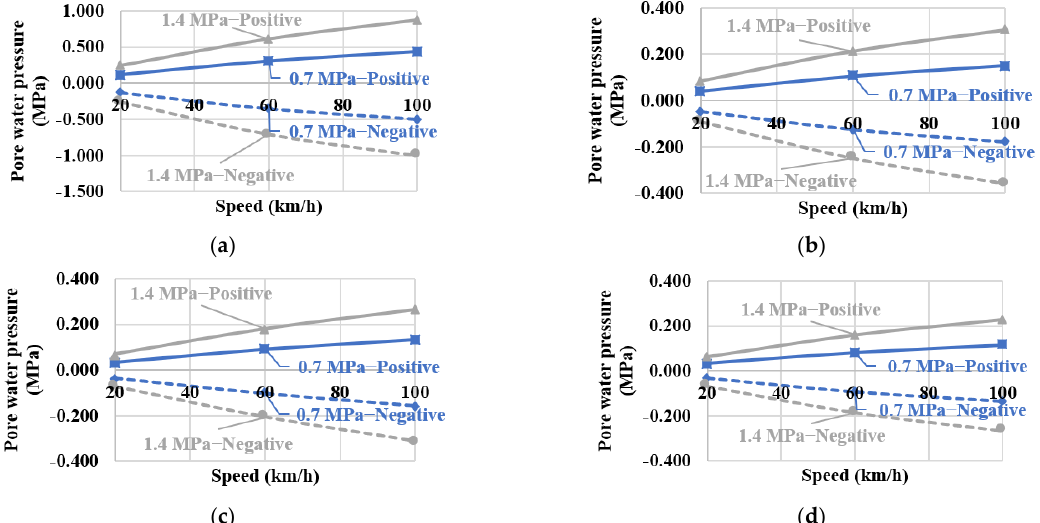
Figure 8. Variation trends of pore water pressure in saturated asphalt pavement: ( a ) Surface layer (h = 0 m); ( b ) Upper layer bottom (h = 0.05 m); ( c ) Middle layer bottom (h = 0.11 m); ( d ) Lower layer bottom (h = 0.18 m).